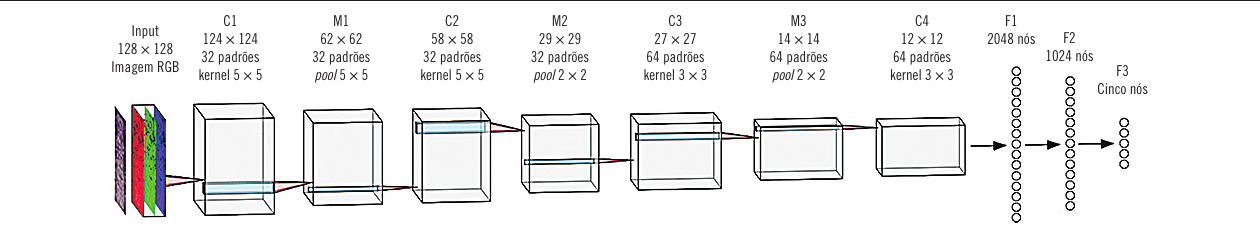
figura 1 – Fluxo de processamento da rede neural convolucional utilizada para a detecção das cinco classes definidas para adenocarcinoma gástrico em lâminas de tecido coradas pelo HE, digitalizadas. As quatro camadas indicadas com C (camadas convolucionais) podem ser consideradas como estágios de extração de feições ( features ), nas quais as características não definidas pelo usuário são consecutivamente extraídas do fragmento de imagem. As camadas indicadas pela letra M são camadas do tipo max-pooling e reduzem o tamanho da imagem, forçando ainda mais iterações entre os fragmentos. As últimas três camadas F são do tipo “classificação” que, com base nas características extraídas, indicam as classes finais de cada amostra HE: hematoxilina e